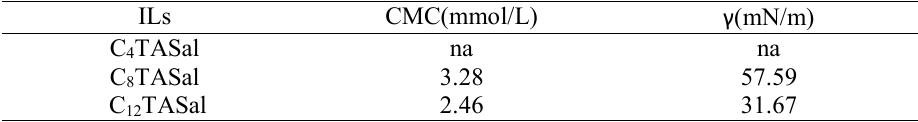
Fig. 1. Concentration-surface tension relationship of the prepared salts in water at 23.5°C. Table 2. Surface activity parameters of C 4 TASal, C 8 TASal, C 12